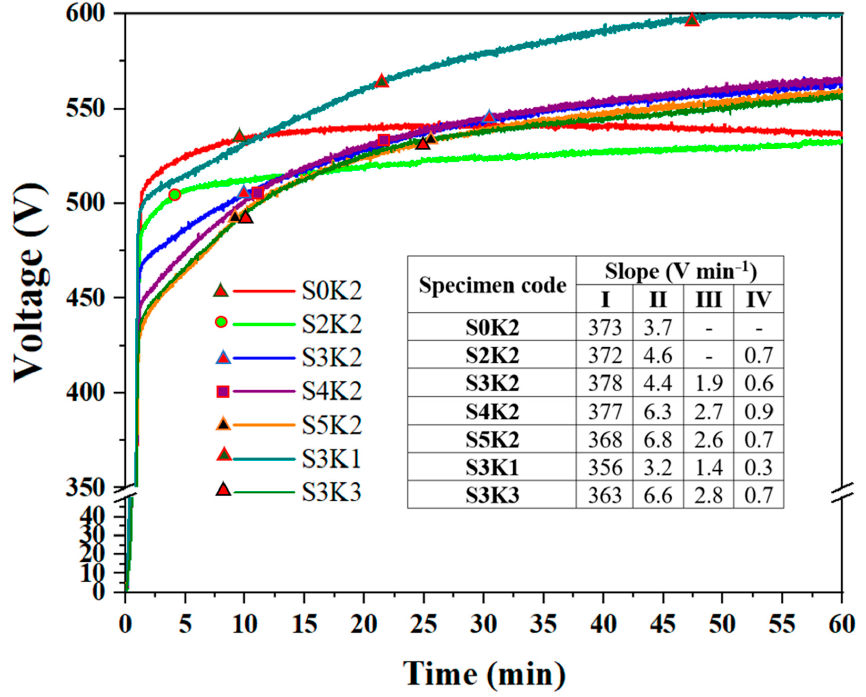
Figure 1. Voltage-time response curve recorded during the PEO process in the various coating solutions. The attached table presents the slope of different PEO stages. The stages are distinguishable by bullets at the end of stages II and III.